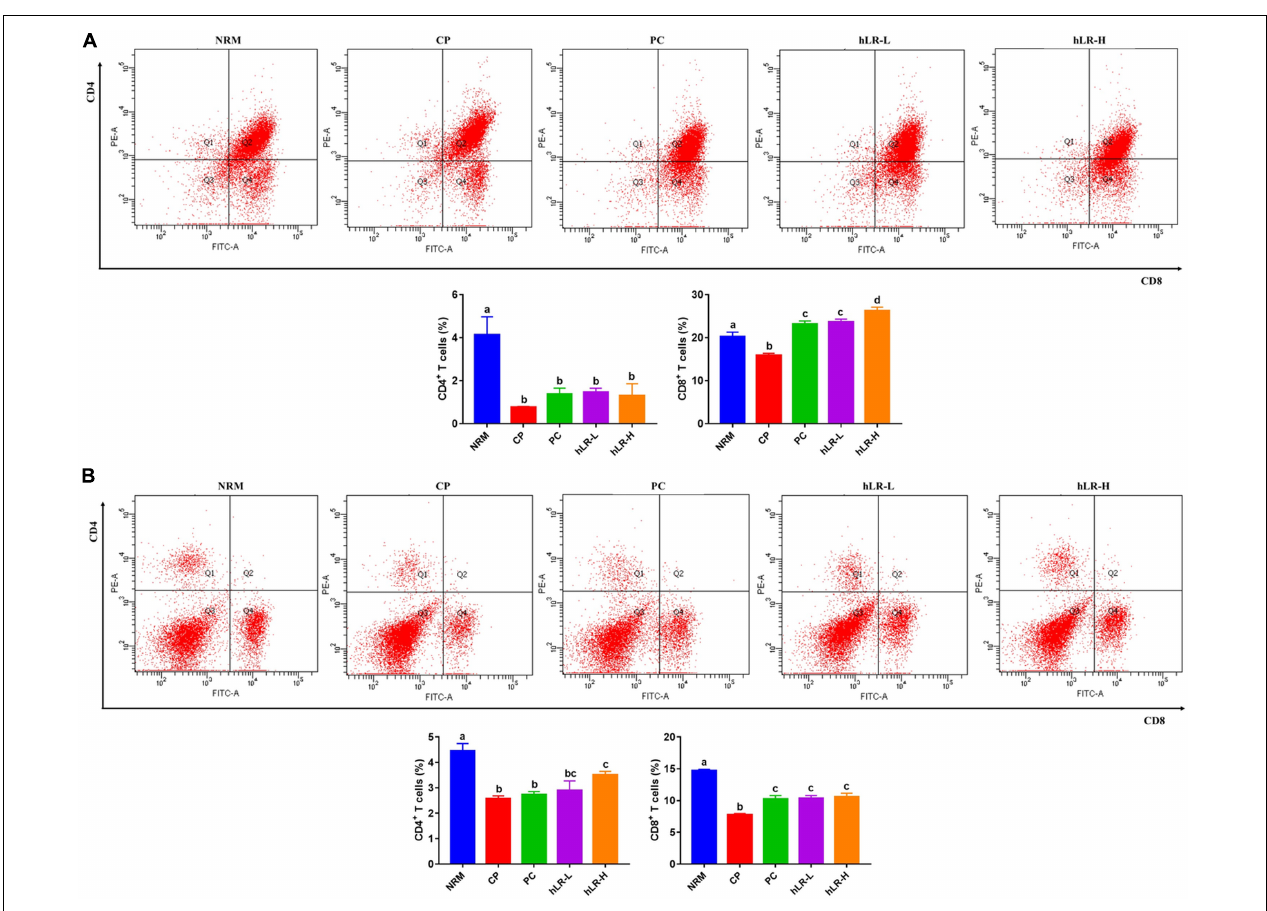
FIGURE 7 | Effects of hLR on thymic and splenic T-lymphocyte subpopulations. (A) Thymic T-lymphocyte subpopulations (CD4 + , region Q1; CD8 + , region Q4). (B) Splenic T-lymphocyte subpopulations (CD4 + , region Q1; CD8 + , region Q4). Data are the mean ± SEM ( n = 4). Different letters above the bars indicate a significant difference between the groups ( p <